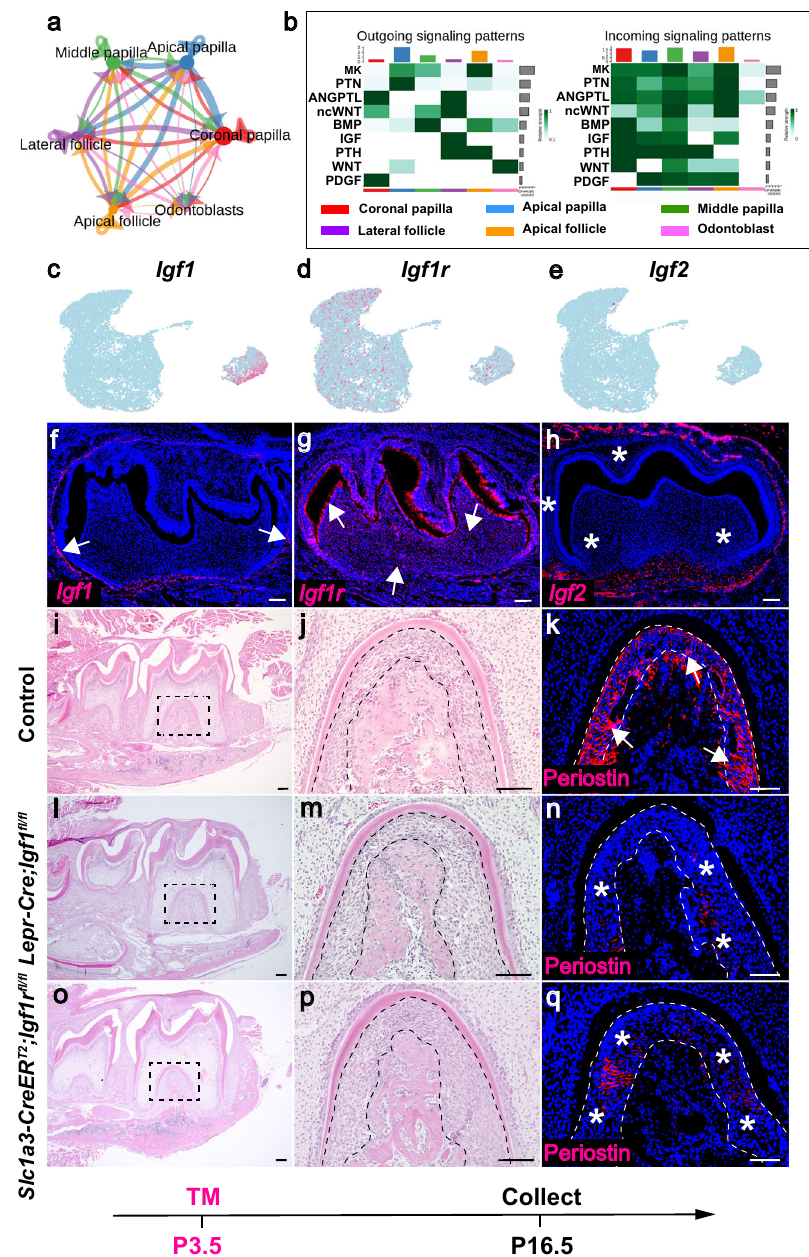
Fig. 7 | Cell – cell interaction in the dental mesenchyme is important for the lineage development of the mouse molar. a NetVisual_circle plot of the number of interactions between the cellular domains in the dental mesenchyme at P3.5. b Outgoing and incoming signalingpatterns between the dental mesenchymal cell populations P3.5. c – h Feature plot and RNAscope staining of Igf1 , Igf1r and Igf2 in